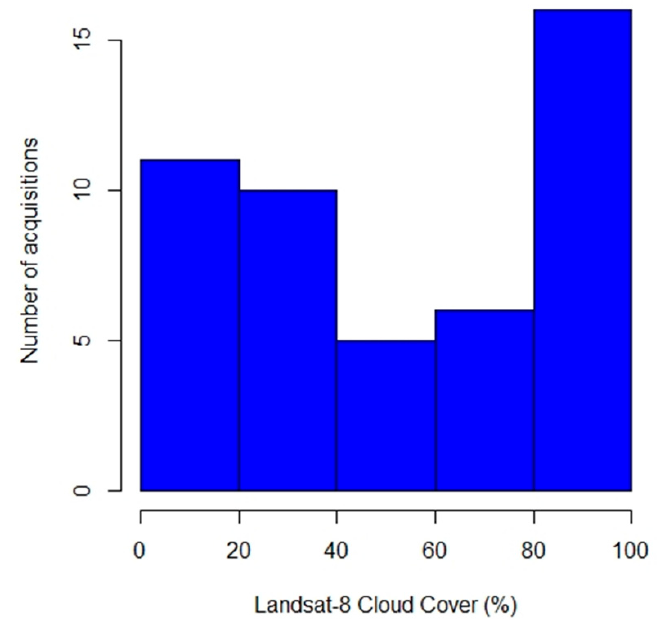
Figure 2. Histogram showing the percentage cloud cover in the 48 Landsat-8 Operational Land Imager (OLI) images acquired over the study area (Landsat Path 180 Row 061, Figure 1) for two years from July 2013 to August 2015. In total, out of 48 images, 11 had a cloud cover < 20%, 23 had cloud cover ≥ 50%, and 16 had cloud cover ≥